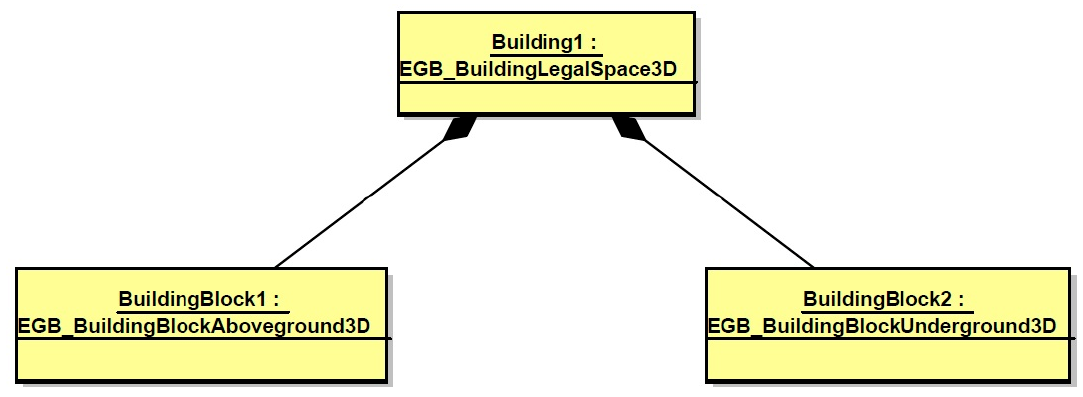
Figure 12. UML schema where access to an underground object is only from one building.